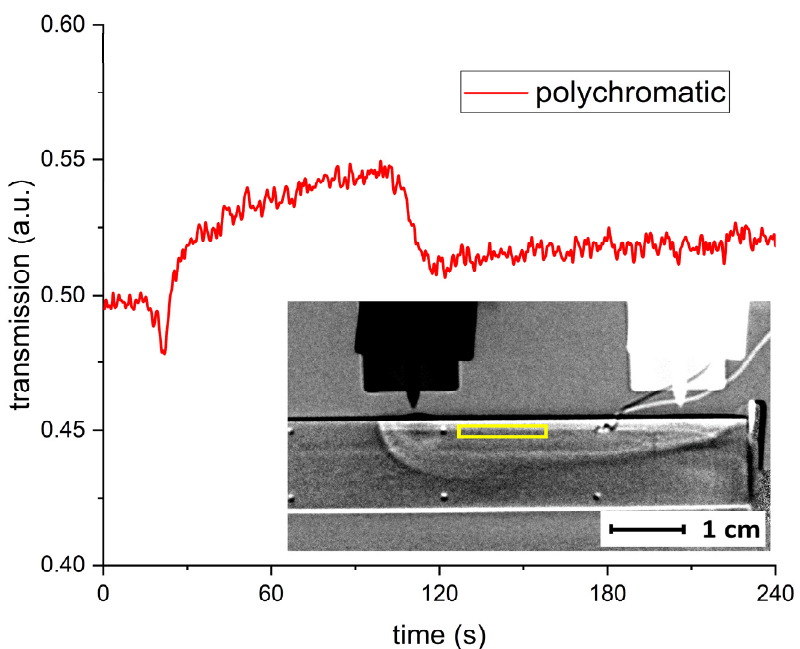
Figure 5. Plot of the transmitted intensity as a function of time taken as mean value from the ROI (yellow rectangle). The insert shows the normalized polychromatic image taken just before switching off the welding torch at the end position.